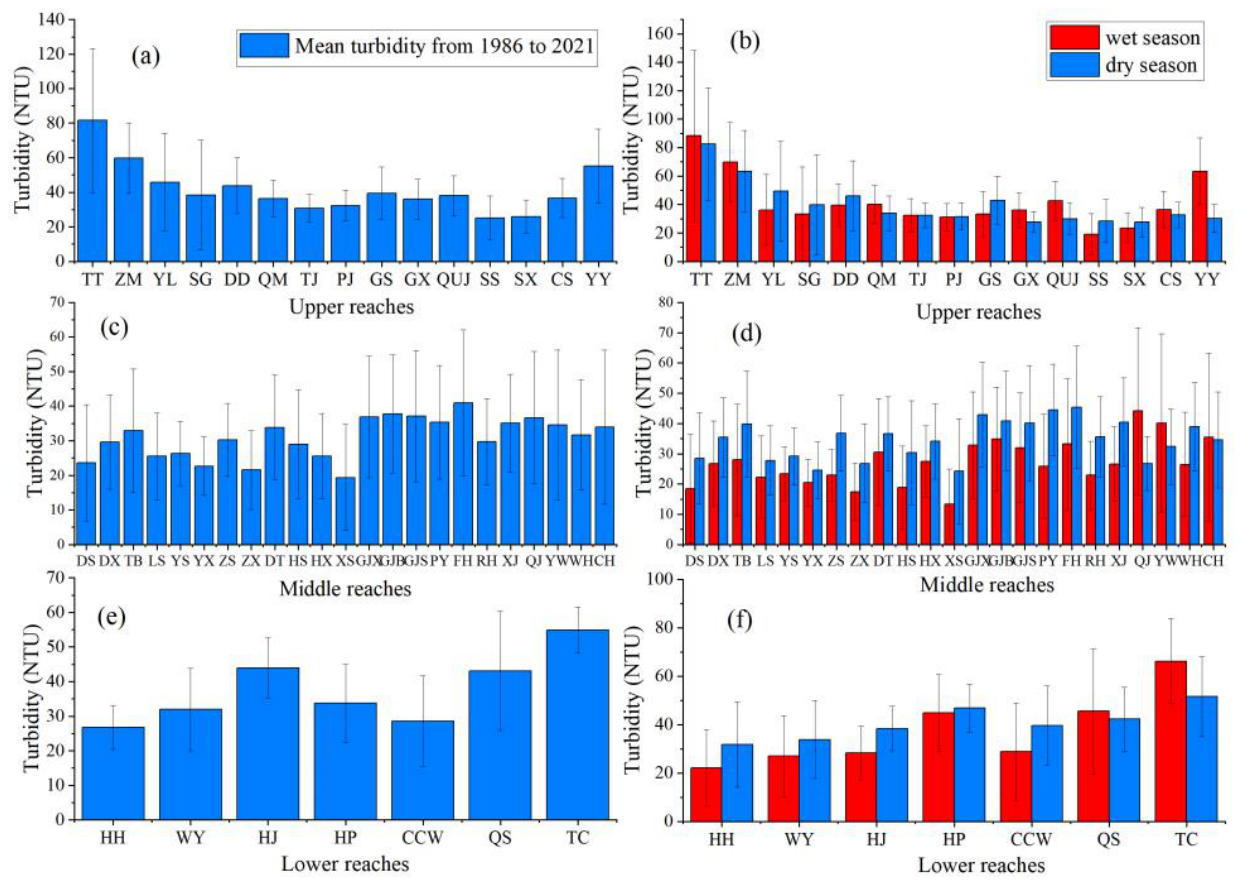
Figure 11. Distribution of mean turbidity in the tertiary basins in the Yangtze River Basin from 1986 to 2021. ( a ) mean of 36 years in the upper reaches; ( b ) mean of wet season and dry season in the upper reaches; ( c ) mean of 36 years in the middle reaches; ( d ) mean of wet season and dry season in the middle reaches; ( e ) mean of 36 years in the lower reaches; ( f ) mean of wet season and dry season in the lower reaches.